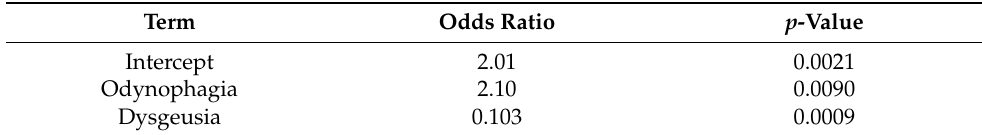
Table 2. Logistic regression variants as a function of symptoms (Delta variant as baseline). Predictors with p < 0.05 are shown.